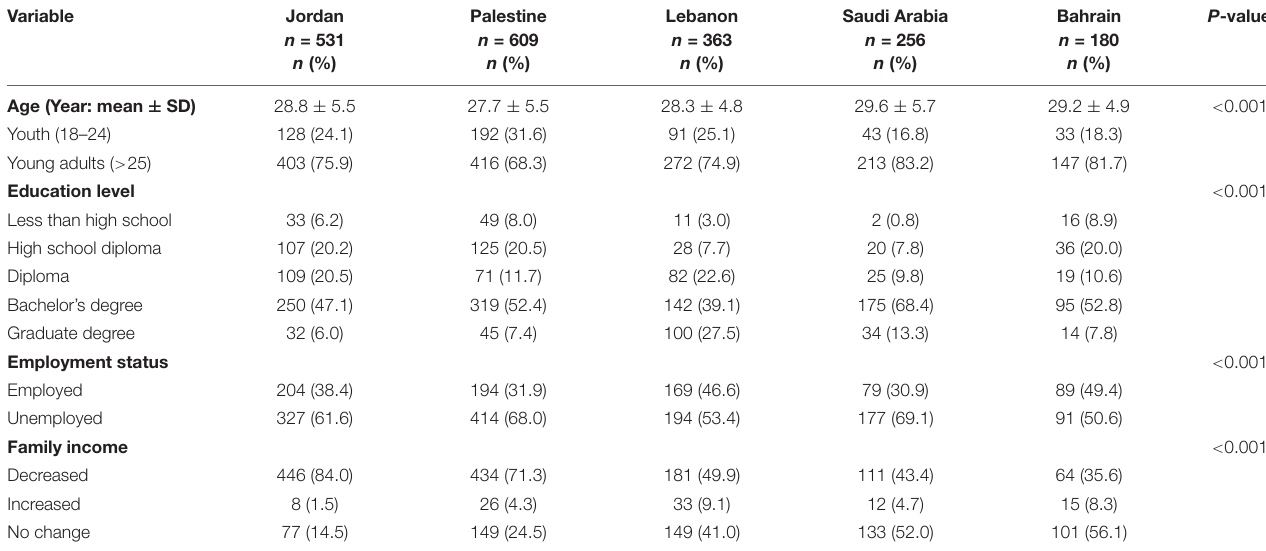
TABLE 1 | Socio-economic characteristics of the study participants, by country.